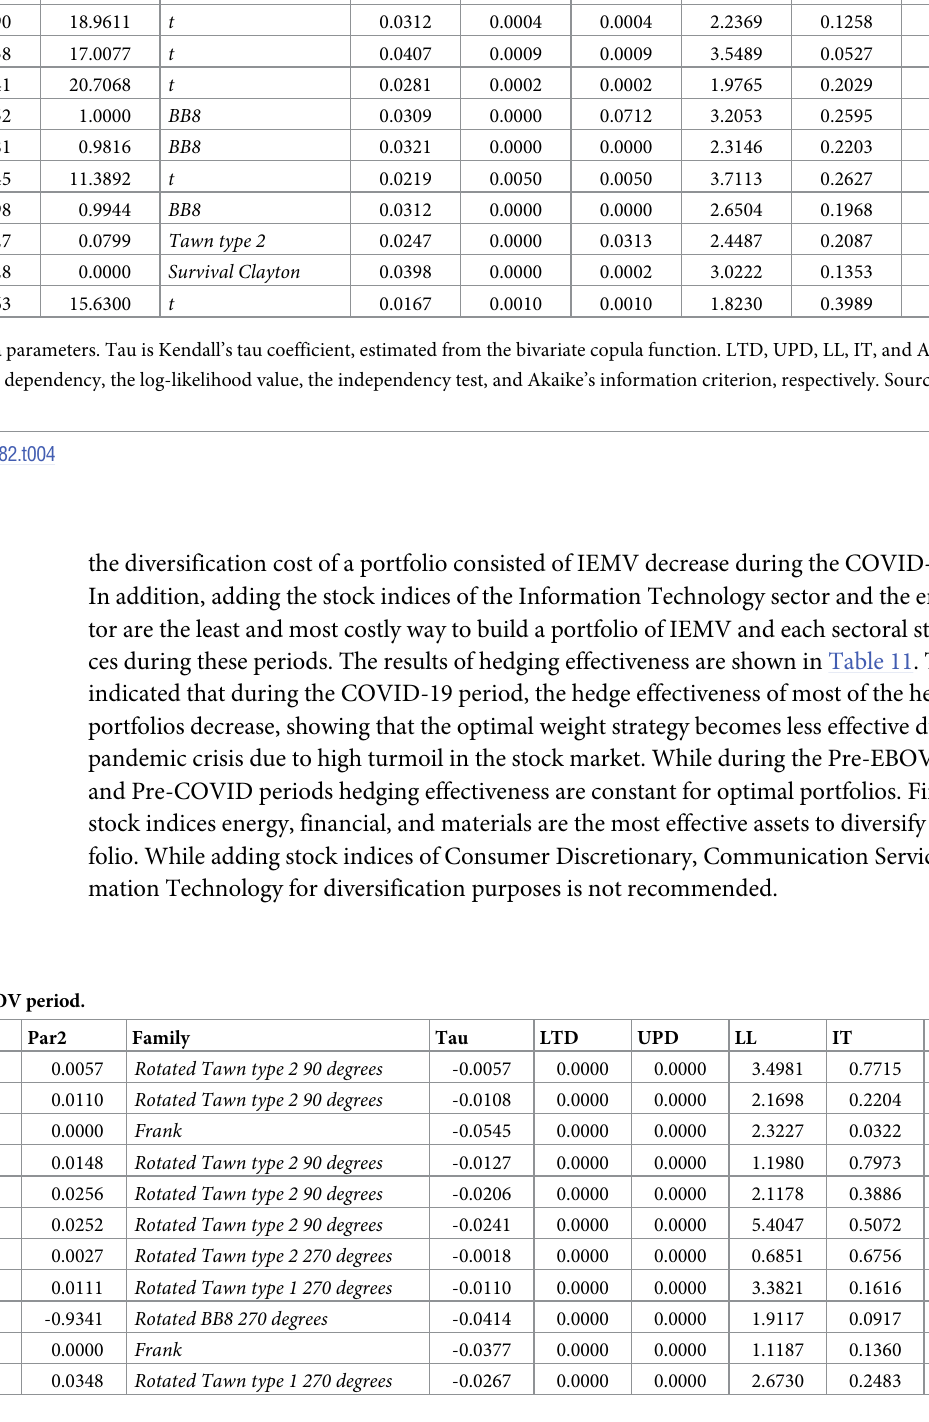
Table 4. Copula results during the Pre-EBOV period.